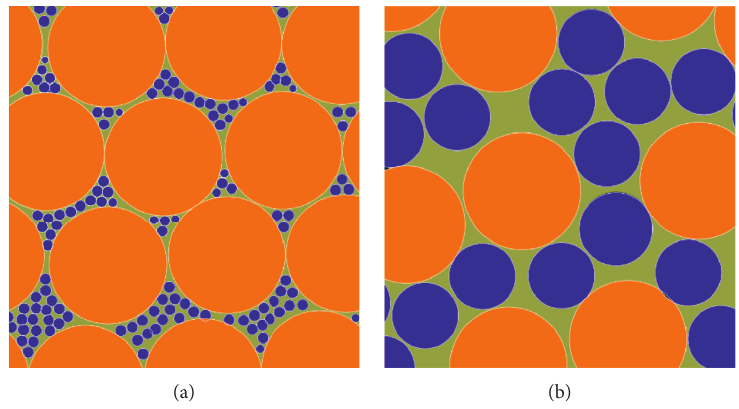
Figure 9: Stacking and filling effect: (a) filling effect; (b) embedding effect.